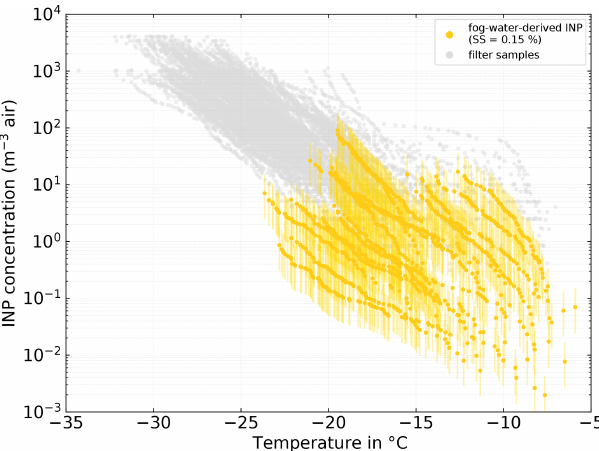
Figure 8. N INP in fog water samples measured with INDA. The teal and orange polygons show the range of values observed by Joly et al. (2014) and Gong et al. (2020), respectively.